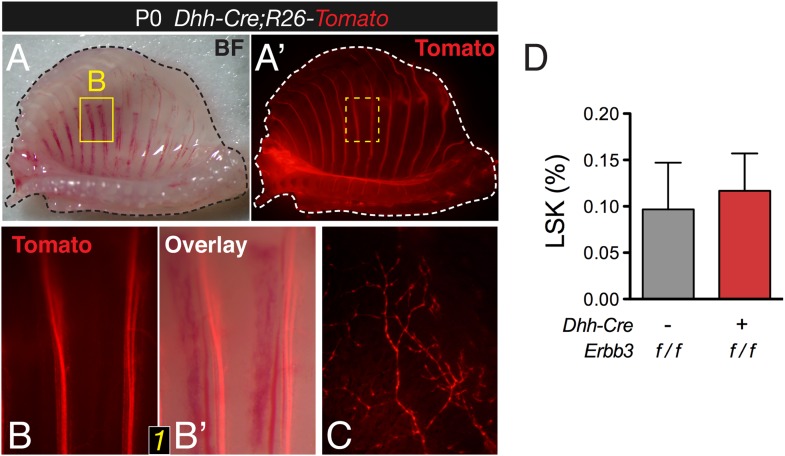
Conditional Erbb3 deletion after glial specification of Schwann cell precursors does not affect bone marrow HSCs.(A-A′) Whole-mount view of ventral ribcage of a Dhh-Cre;R26-Tomato neonate, showing labeling of glial cells along the intercostal peripheral nerves (red). (B-B′) Surface detail of Tomato+ Schwann cells between 2 ribs. (C) High magnification of ventral skull showing an intricate network of Tomato+ Schwann cells. (D) Frequency of hematopoietic lineage− c-Kit+ Sca-1+ (LSK) cells in neonatal bone marrow of Dhh-Cre;Erbb3f/f and control littermate mice (mean ± SD, n = 4–5).